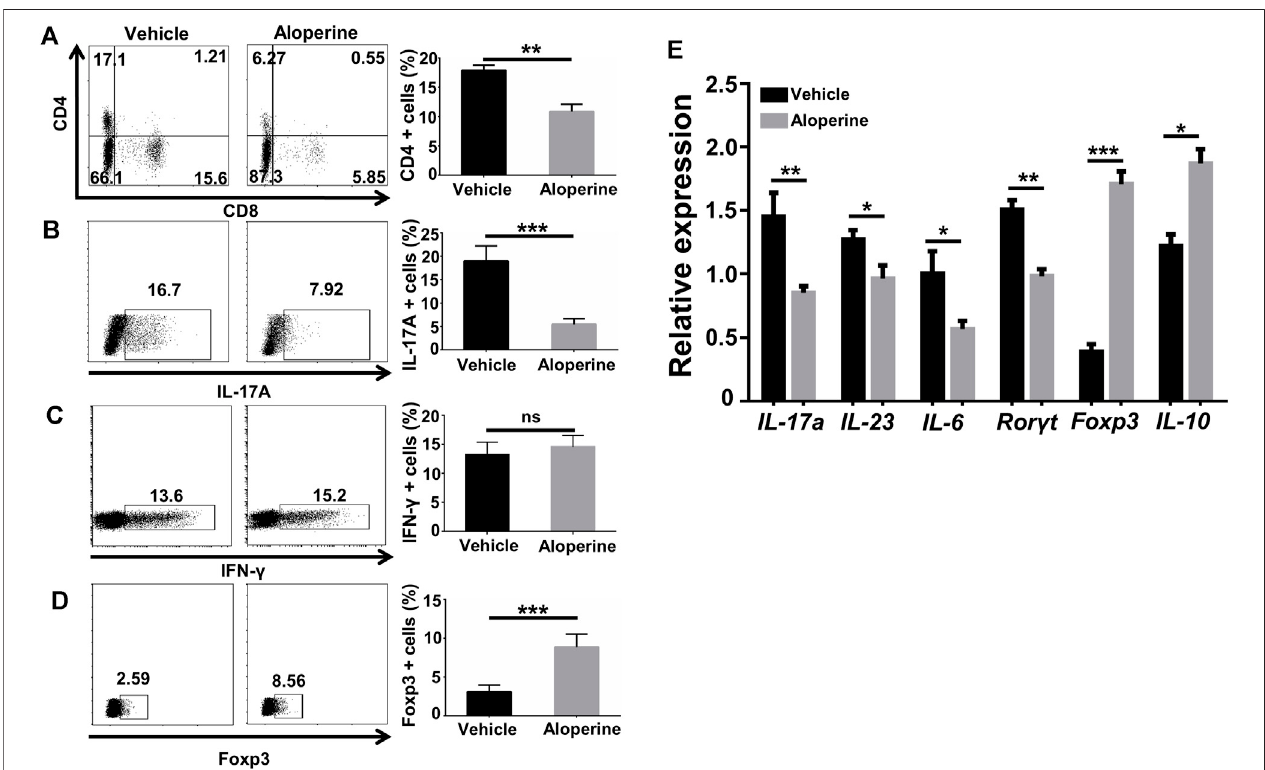
FIGURE4| AloperinedecreasestheTh17/Tregratiointhepsoriasis-likelesions. (A – D) FlowcytometryanalysisforCD4,CD8,Th1,Th17,andTregcellsintheskin lesions. (E) Real-time PCR analysis of IL-17A, IL-23, IL-6, ROR γ t, Foxp3, and IL-10. The values are presented as the mean ± SEM ( n = 8 mice per group). p p < 0.05; pp p < 0.01; and ppp p <